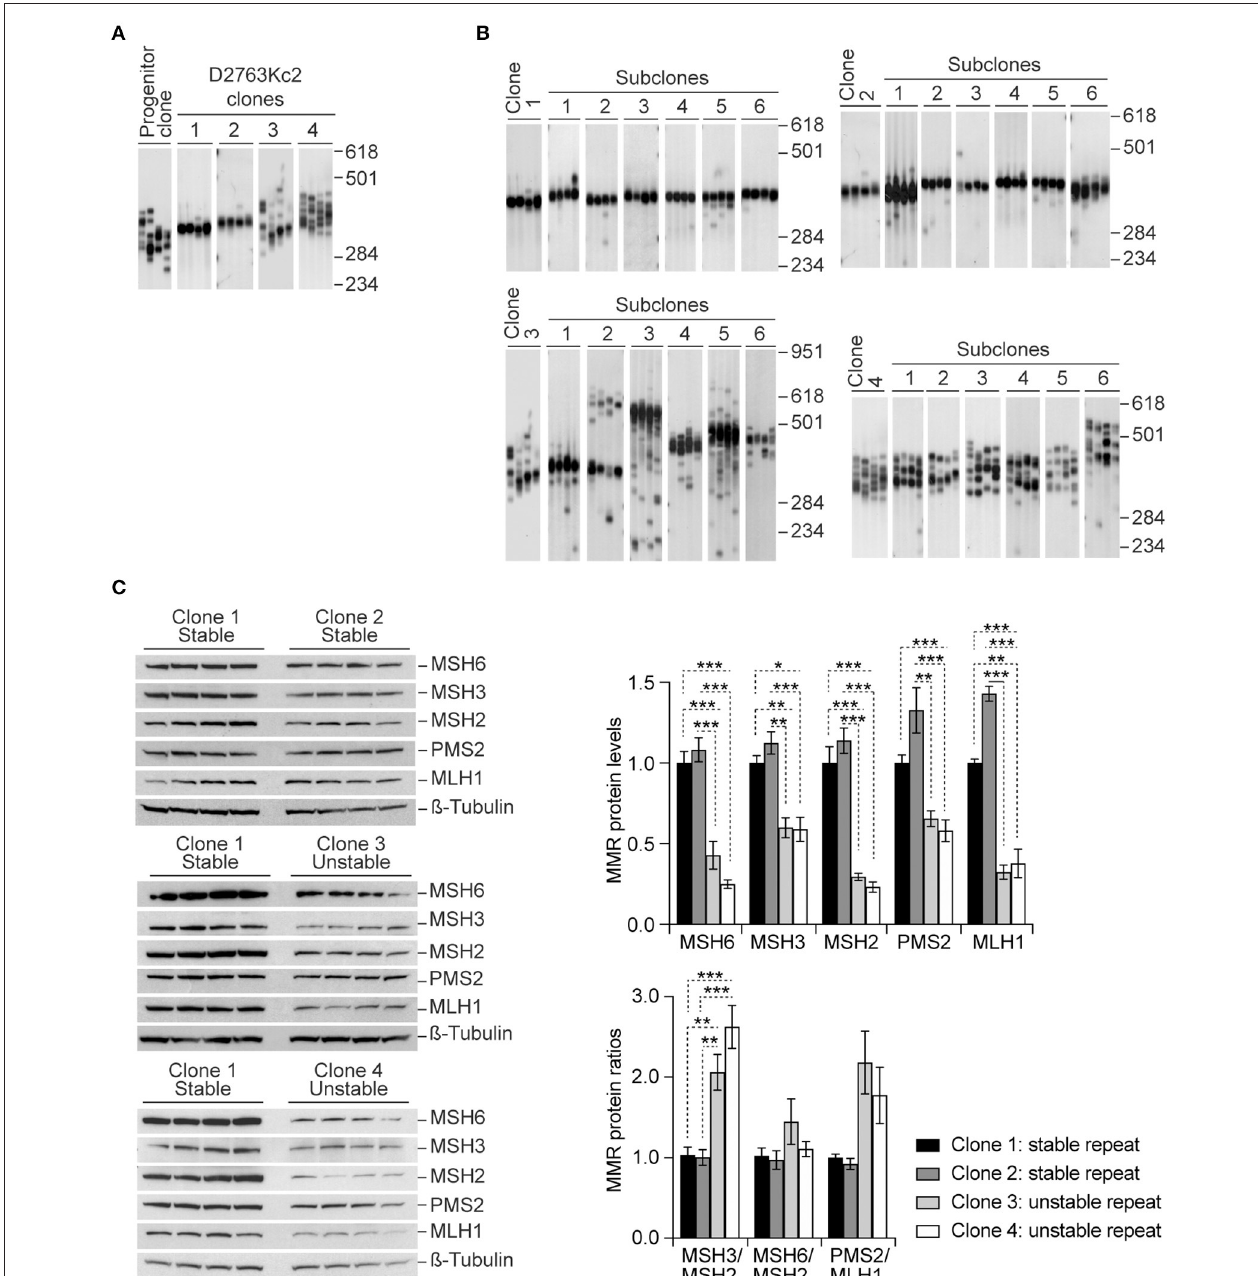
FIGURE 1 | Higher CAG • CTG repeat size variability is associated with higher MSH3/MSH2 protein ratios in homogenous single cell clones. (A) Representative SP-PCR analyses of the expanded CAG • CTG trinucleotide repeat in D2763Kc2 cell clones. Single-cell clones were derived from the progenitor culture by limiting dilution and grown for 20 population doublings ( ∼ 20 to 40 days). (B) Representative SP-PCRs of the expanded CAG • CTG repeat in sub-clones derived from four selected D2763Kc2 clones showing different repeat dynamics. For clarity, only six representative sub-clonal cultures are shown. The scale on the right indicates the DNA molecular weight markers converted into number of CAG • CTG repeats. (C) Quantification of MMR protein levels in selected D2763Kc2 clones. Independent single cell clones were established from the same progenitor culture. Four clones were selected for analysis. Four protein lysates were collected from each clone, electroblotted and probed with anti-MMR proteins. ß-Tubulin was used as loading control. The top graph shows the average protein levels relative to normalized control clone 1. The bottom graph shows the average MMR protein ratios relative to normalized control clone 1. The error bars indicate ± SEM. Statistically significant changes are indicated (* p < 0.05, ** p < 0.01, *** p < 0.0015; Two-way ANOVA, Tukey post-hoc correction for multiple comparisons).